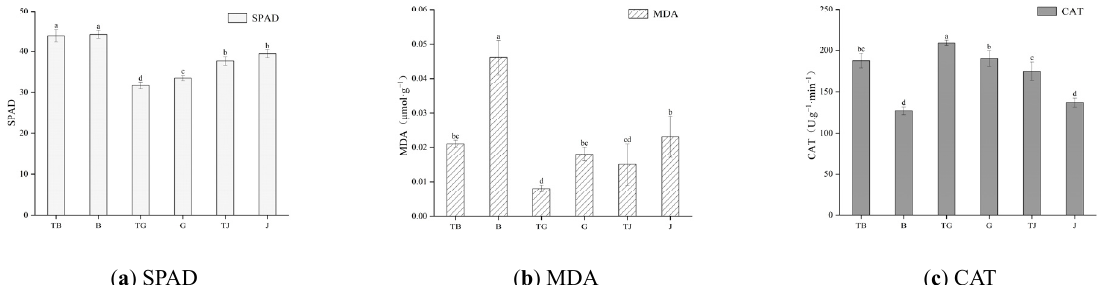
Figure 1. Changes in physiological indexes of Cr-tolerant garden plants under different treatments. Note: different letters in the same column in the figure indicate that the difference between different treatments is significant ( p < 0.05). The data in the table are the mean ± standard deviation of 3 repetitions.